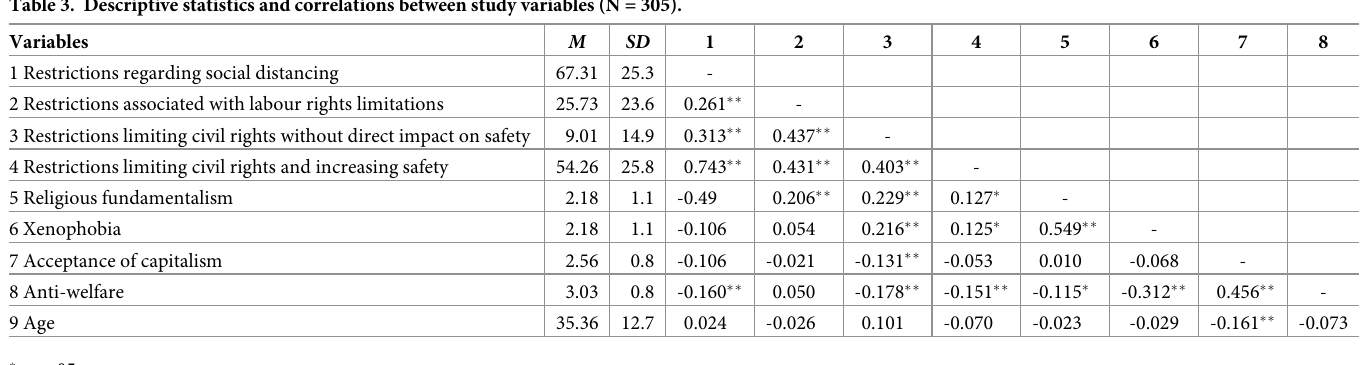
Table 3. Descriptive statistics and correlations between study variables (N = 305).